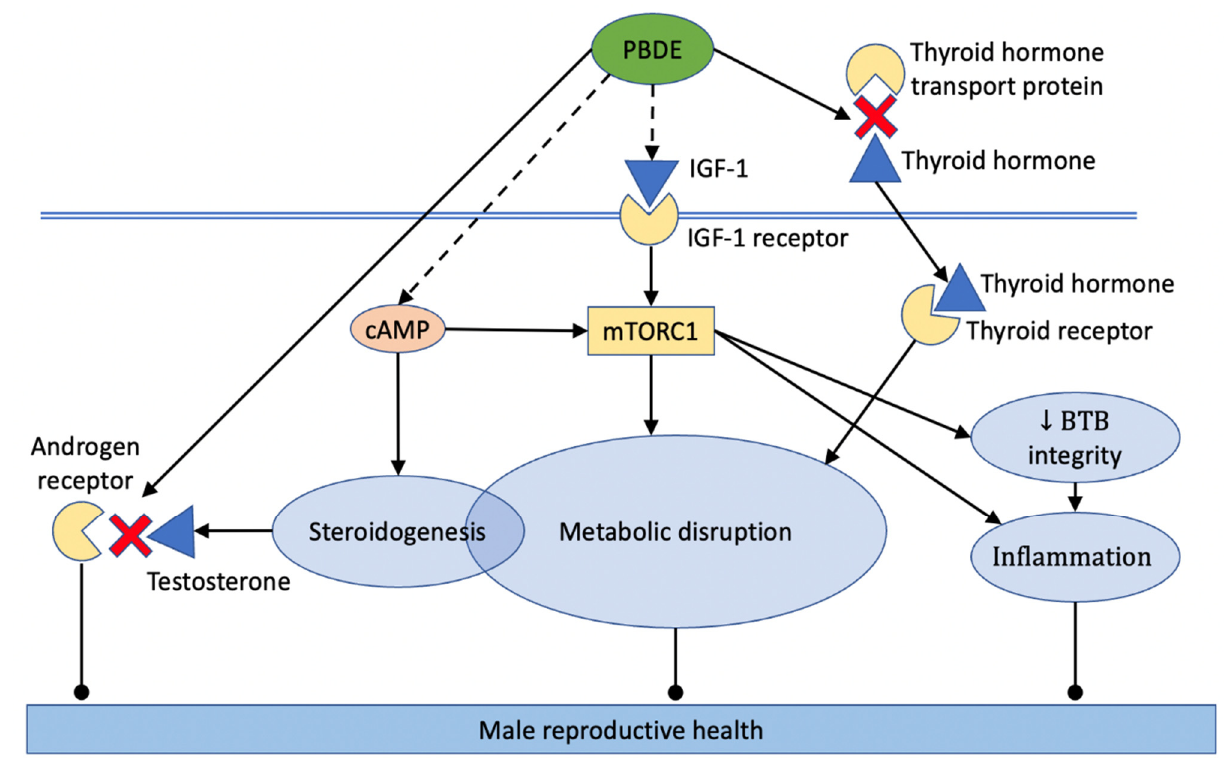
Figure 3. Summary of mechanisms involved in male reproductive toxicity of PBDE. (1) Many PBDEs and their metabolites may disrupt testosterone signaling via antagonistic interaction with the androgen receptor. (2) PBDEs increase the production of cAMP via an unknown mechanism. cAMP is a central regulator of steroidogenesis and altered cAMP production may result in altered availability of testosterone. cAMP is also involved in mTORC1 activation. (3) PBDEs increase circulating IGF-1, which activates mTORC1 signaling. mTORC1 positively regulates anabolic metabolic pathways and immune response. mTORC1 activity also promotes permeability of the blood–testes barrier. Increased permeability of the blood–testes barrier may result in autoimmune response and testicular inflammation. (4) PBDE and their metabolites compete with thyroid hormone for thyroid hormone transporting proteins in the blood. Replacement of thyroid hormone from transporting proteins alters the bioavailability of hormones and affects thyroid